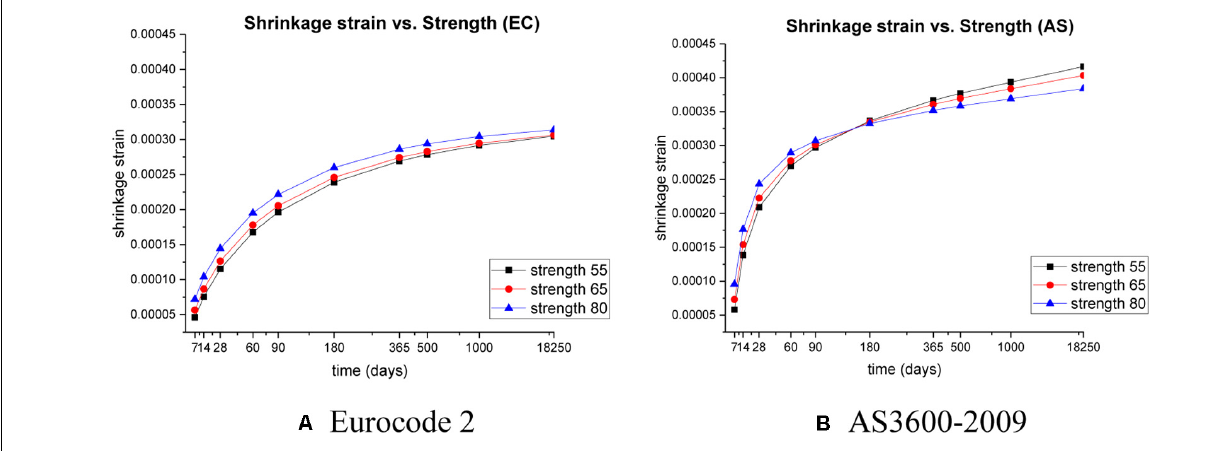
FIGURE 5 | Strength–shrinkage relationship. (A) Euro Code 2 and (B) AS3600-2009.